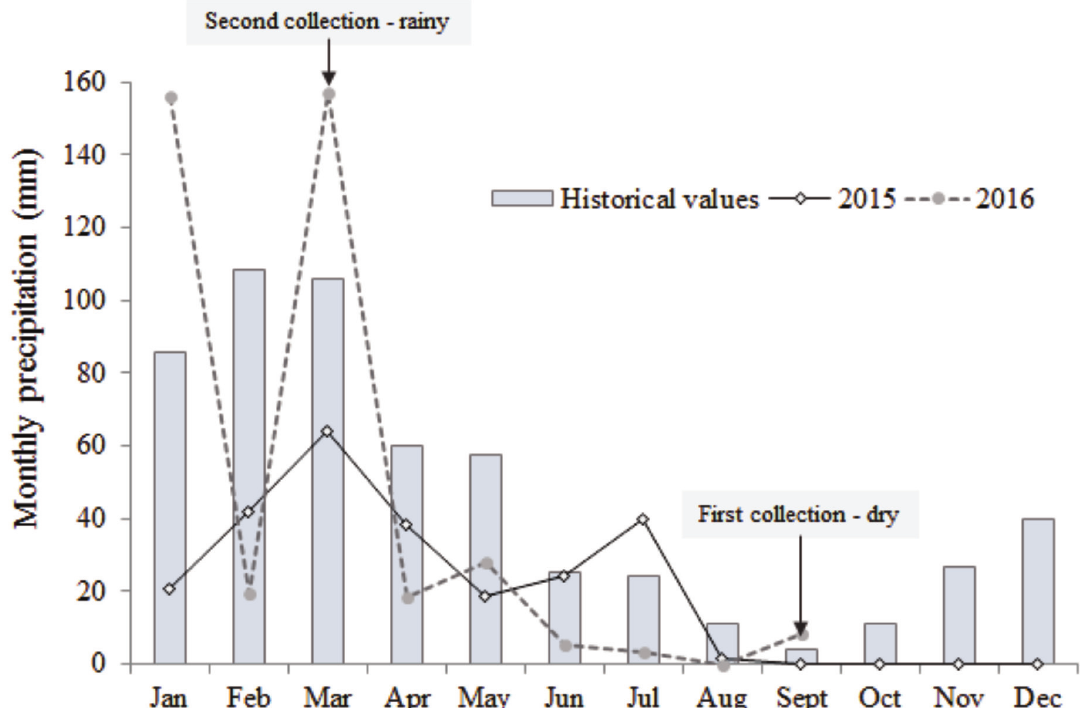
Figure 2 - Historical rainfall mean of the last 10 years and during the study period, with emphasis on the sampling months, in the three reservoirs in a tropical semiarid basin (Pajeú